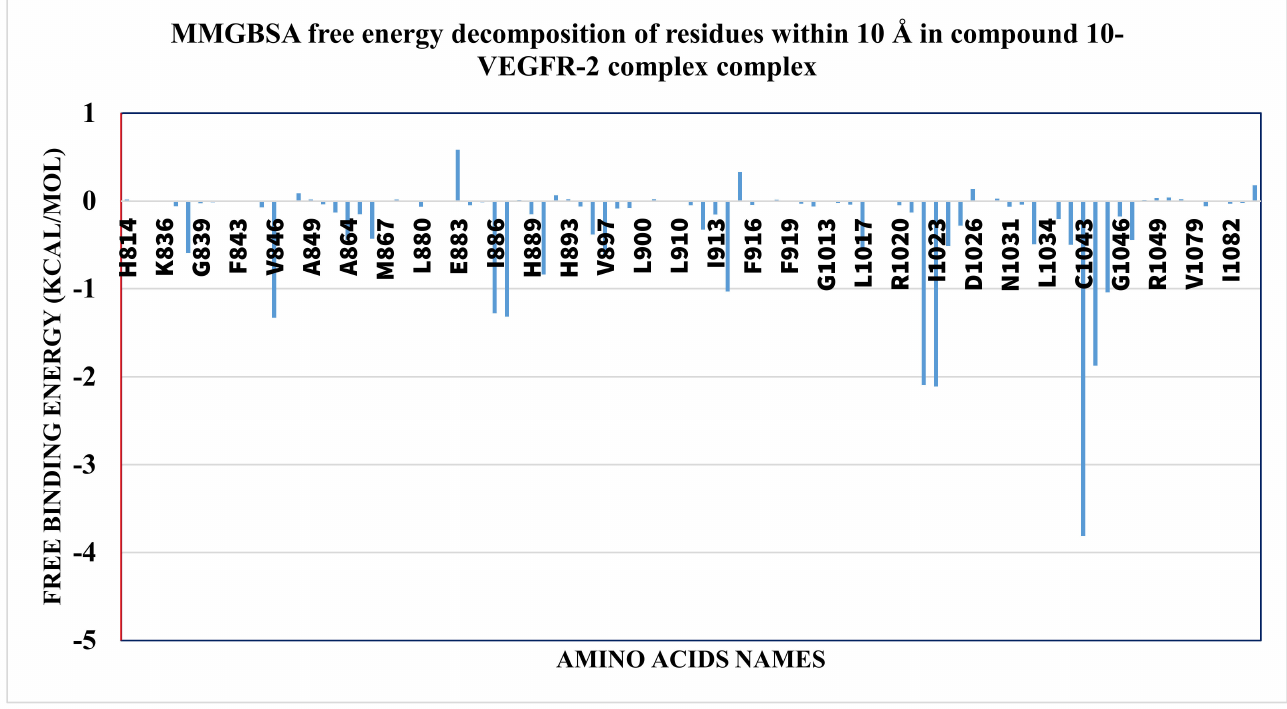
Figure 8. Decomposition of the free binding energy of amino acids around 10 Å of the compound 10- VEGFR-2 complex.